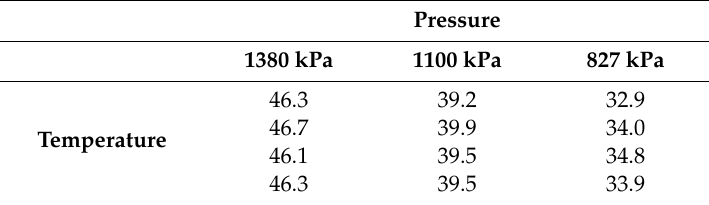
Table 4. Average air temperatures ( ◦ C) for each compressor discharge pressure.